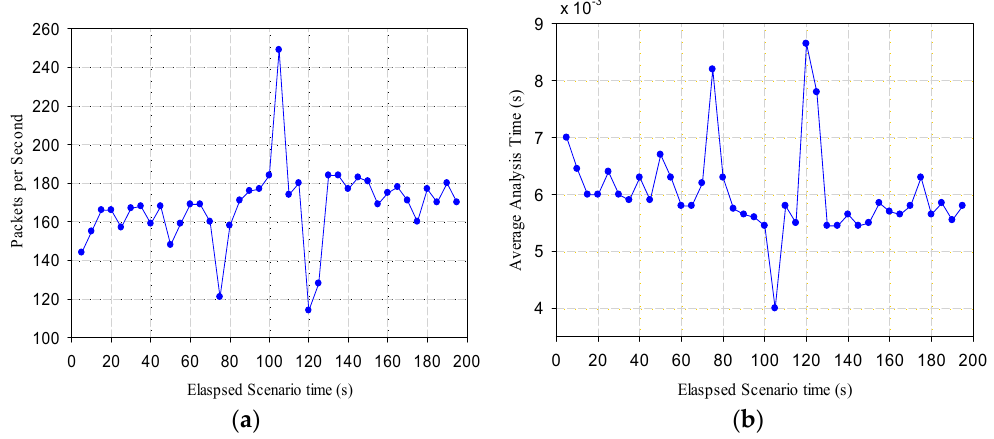
Figure 14. ( a ) parsed packets per second; ( b ) average parsing time of one packet.